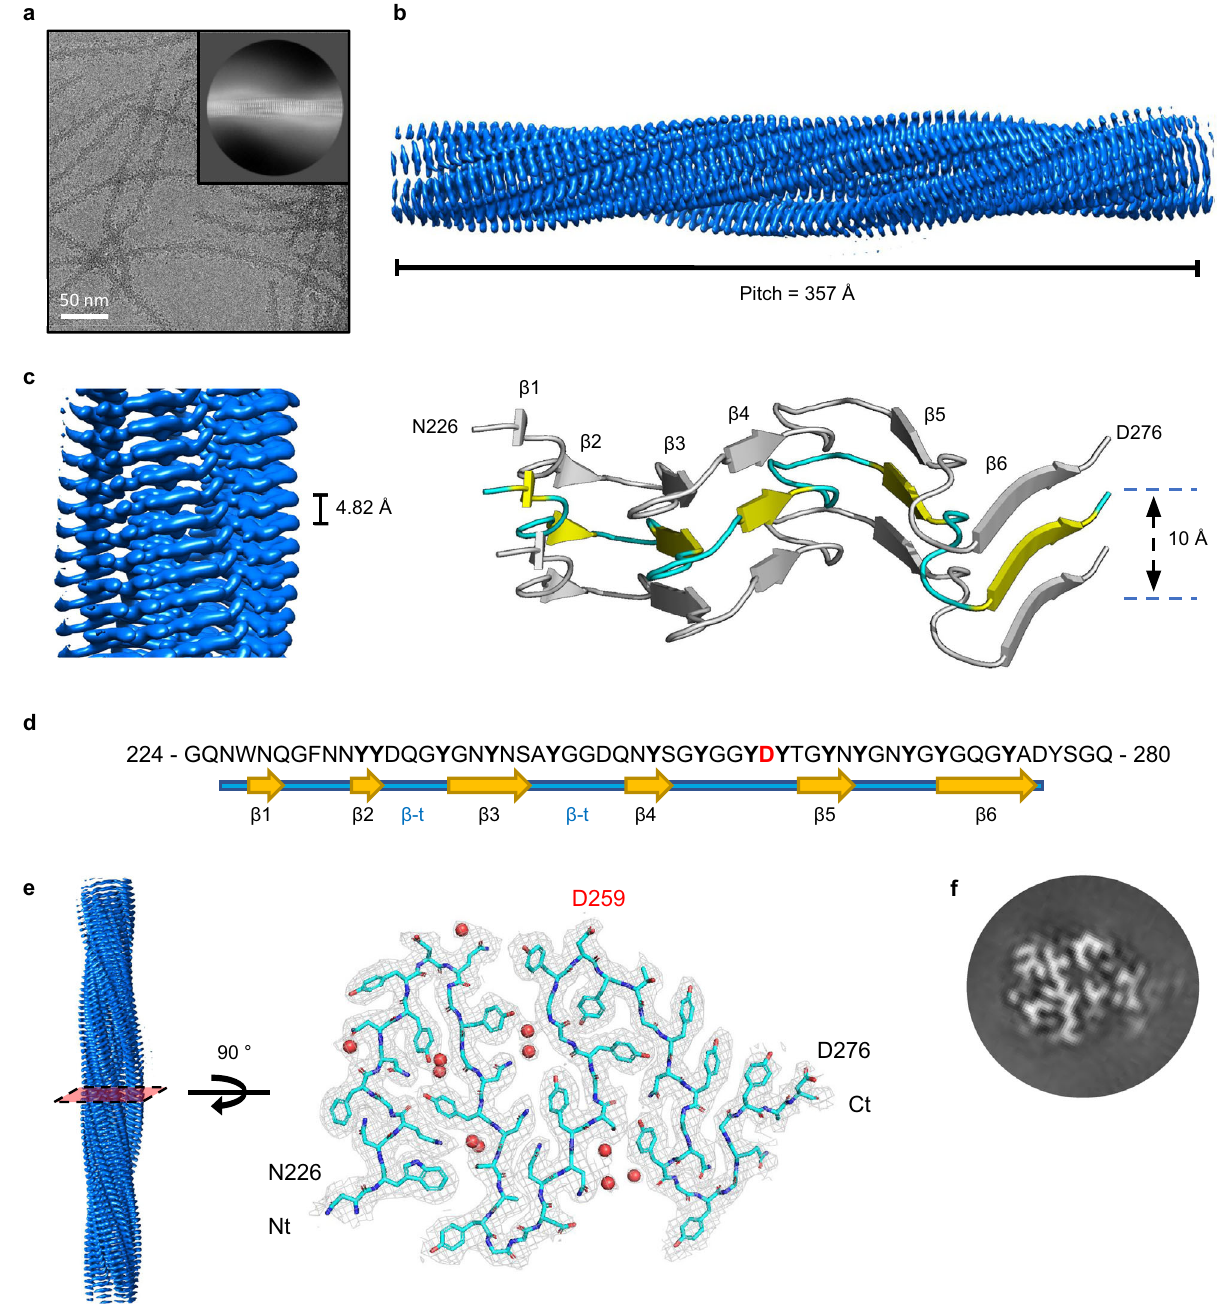
Fig. 2 | Structure of hnRNPDL-2 amyloid fi laments. a Cryo-electron micrograph of hnRNPDL-2 fi laments. Representative image from 1114 micrographs. The inset shows a representative reference-free 2D class average image of the hnRNPDL-2 fi lament. Scale bar, 50nm. b Side view of the three-dimensional cryo-EM density map showing the structured core of an individual hnRNPDL-2 fi lament. The fi bril pitch is indicated. c Detailed view of the cryo-EM density map showing the layer packing in the hnRNPDL-2 fi lament (left panel). The fi lament rise/subunit is indi- cated inÅ.Rendered side view ofthe secondarystructureelementsaccounting for